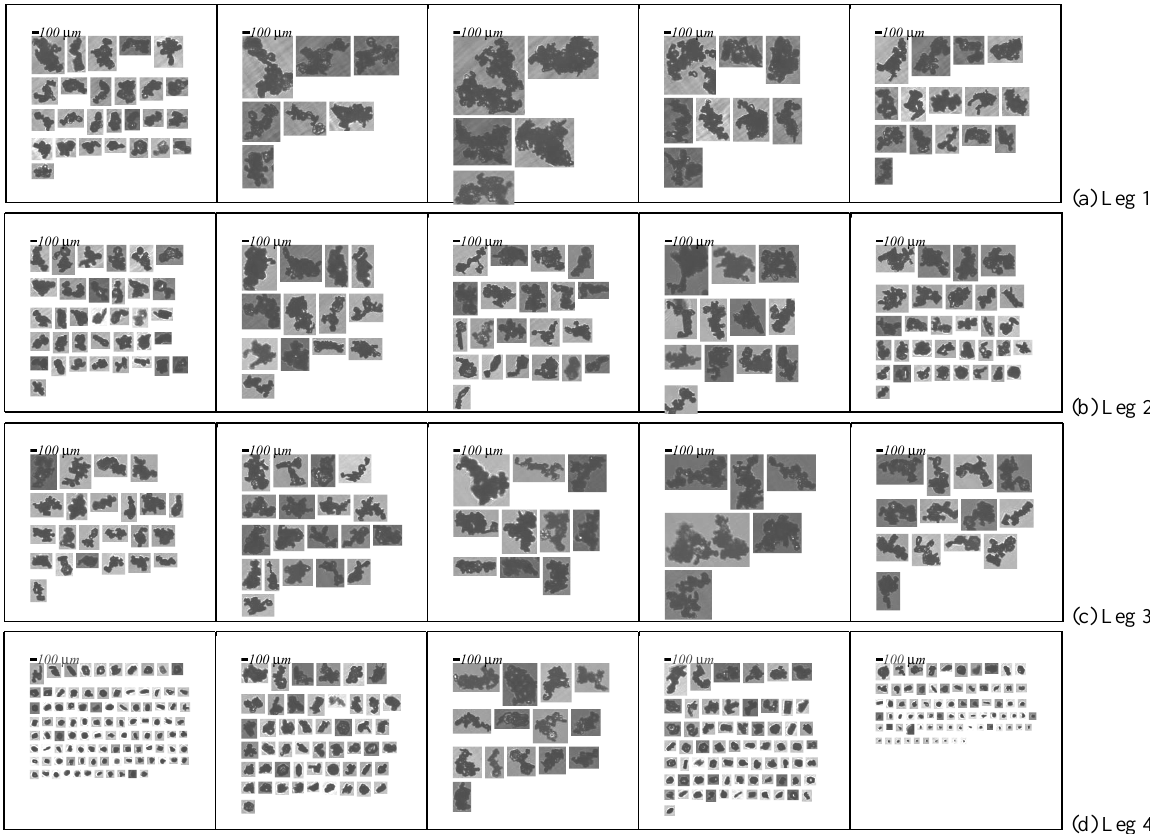
Fig. 8. CPI unprocessed images recorded during cloud penetrations 1 to 4 perpendicular to the storm outflow with increasing distances, 19, 31, 67 and 93km, figures (a) to (d) respectively, from the storm—see Table 1 for flight leg numbers and Figs 1 and 2 for the location of the aircraft during those legs. The crystal images observed are represented in a matrix with the horizontal axis split into 5 latitude bands of width 0.2 ◦ , perpendicular to the outflow direction. The vertical axis is sorted as a function of the maximum ice crystal size (from 5 to ∼ 1120µm) observed in each latitude bin. The size scale at the top of each column represents 100µm.